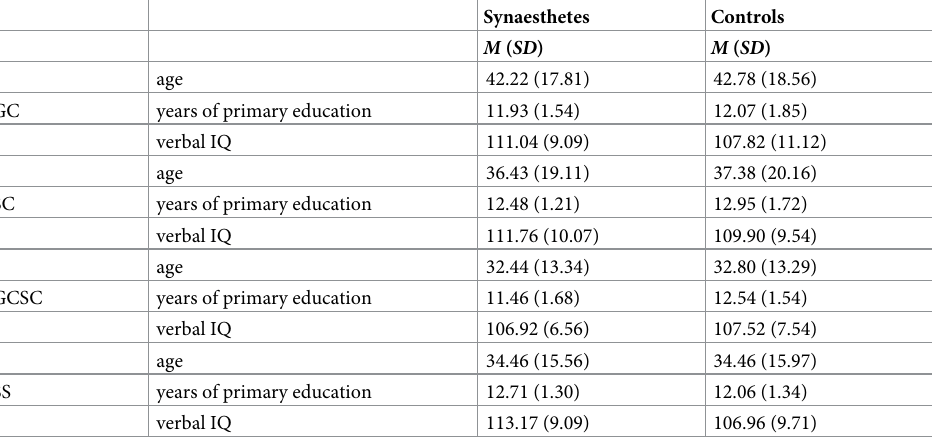
Note . GC = Grapheme-colour synaesthetes; SC = Sound-colour synaesthetes; GCSC = Grapheme-and-Sound-colour synaesthetes; SS = Sequence-Space synaesthetes. Verbal IQ was tested with a standardized vocabulary test